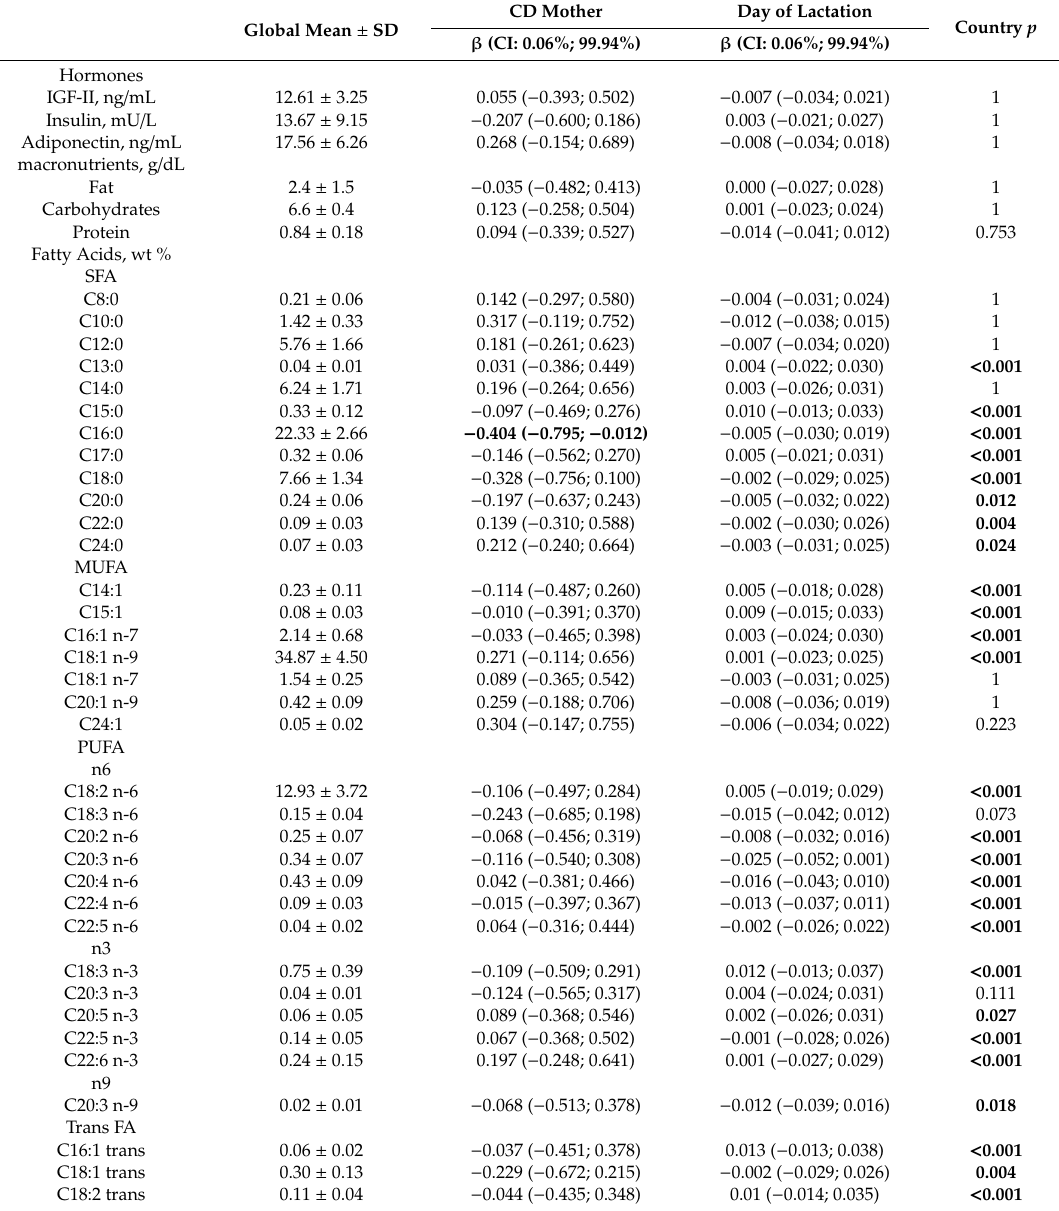
Table 3. Mean analyte concentrations ( ± SD) of late samples collected between days 101 to 163 of